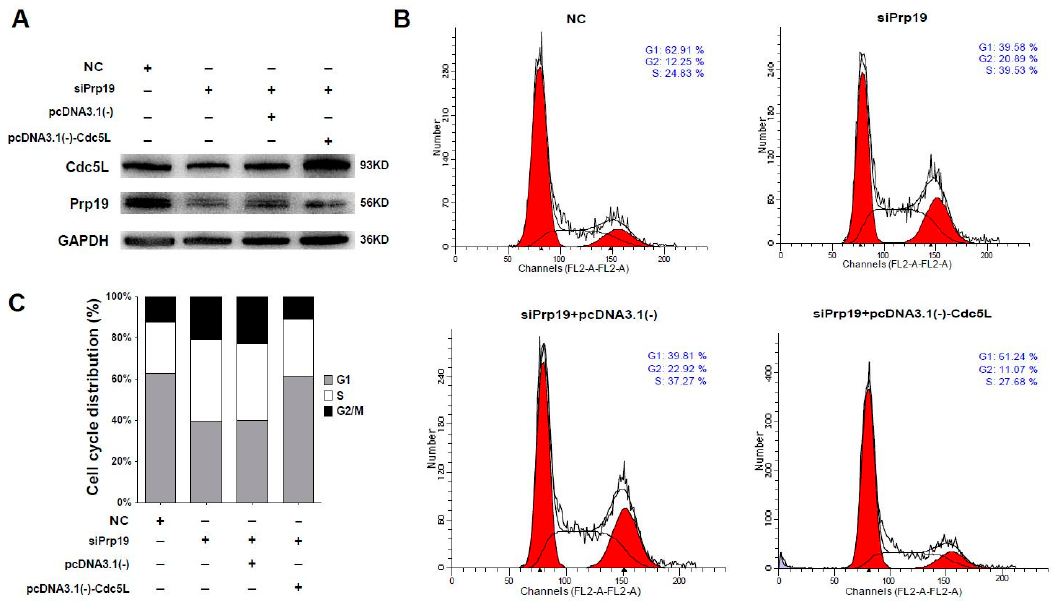
Figure 4. Prp19 regulates mitotic progression via Cdc5L in HCC cells. ( A ) Huh7 cells were transfected with indicated siRNAs. After 24 h transfection, these cells were transfected with indicated plasmids for another 48 h, and followed by western blot; ( B ) Flow cytometry analysis of cell cycle distribution of cells transfected with indicated siRNAs and plasmids in ( A ); ( C ) Quantification of cell cycle shown in ( B ). Data were representative of three independent experiments. NC, control siRNA.